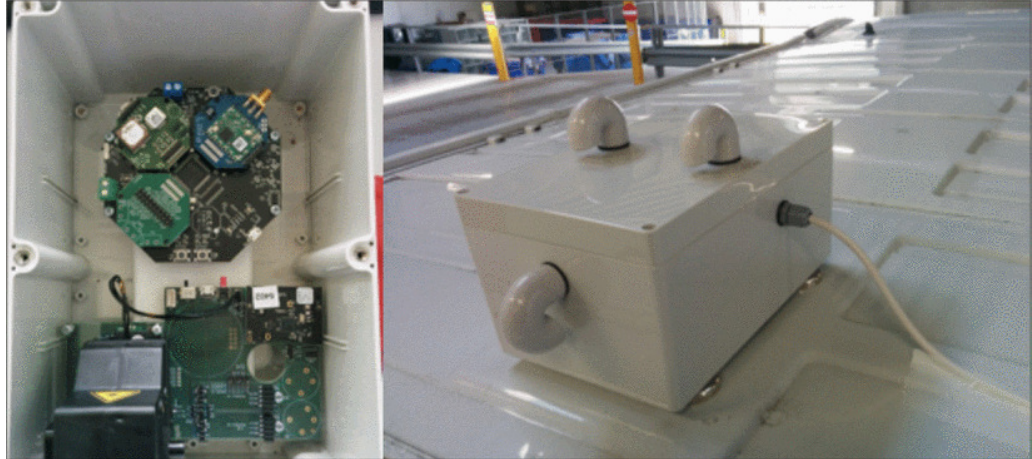
Figure 7. Setup of air quality sensors installed on the roofs of the Bpost delivery vans as part of the Bel-Air